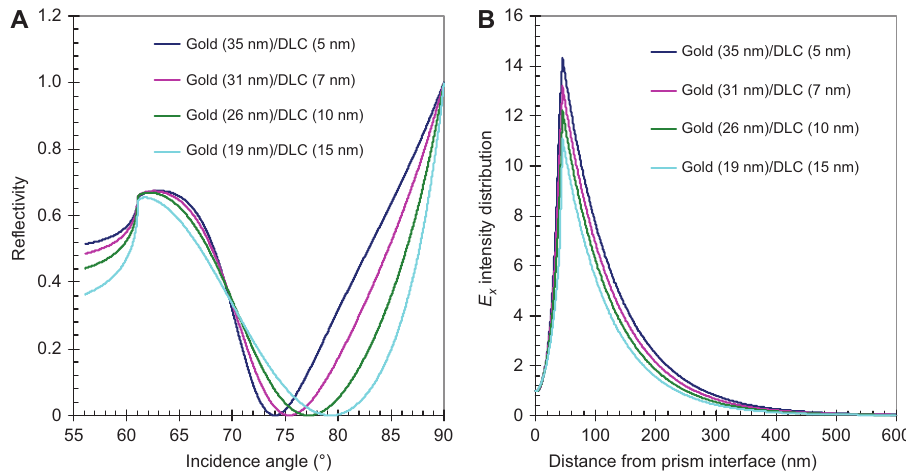
Figure 15 (A) Infl uence of amorphous carbon top layer thickness on the gold thin fi lms on the SPR characteristics for several structures; intensity distribution of the same structures as in (A); parameters used for calculations: n (B) E x = 5 nm, n(DLC) = 2.19 + d Ti